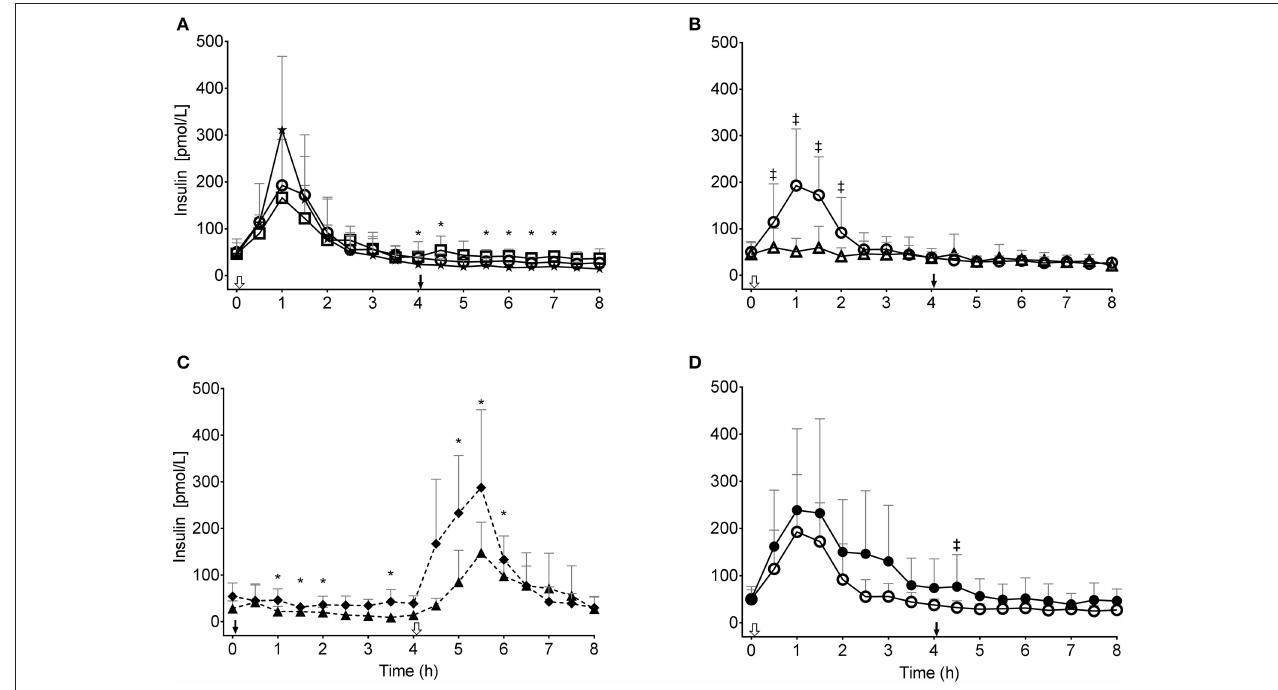
FIGURE 4 | Plasma insulin concentration during the tests: (A) without consuming kMCT (CTL, ⋆ ) or after 10g or 20g of kMCT (kMCT10, ; kMCT20, 2 ); (B) after 10g of kMCT with a carbohydrate-rich (kMCT10, ) or low carbohydrate (kMCT10LC, 1 ) meal; (C) after no meal or kMCT at T0 but a meal at T4 (MS-CTL; (cid:7) –– (cid:7) ), or no meal at T0 but a meal plus kMCT10 at T4 (MS-kMCT; N –– N ; (D) Older (•) vs. Young ( ) after kMCT10 at T0. The black arrow indicates when the meal plus kMCT were consumed and the white arrow indicates when kMCT alone was consumed without the accompanying meal. Values are presented as mean ± SD ( n = 6–10). *Difference with CTL; ‡ Difference between the different test conditions ( P <